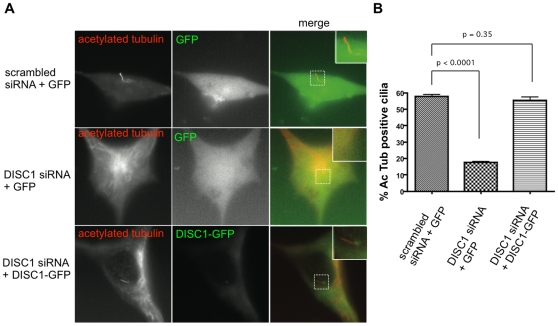
Rescue of the DISC1 knockdown phenotype by human-derived DISC1-GFP.NIH3T3 cells were transfected with siRNA targeting endogenous murine DISC1 and transduced with lentiviral particles encoding human-derived DISC1-GFP lacking the target sequence. (A) Example images from the rescue experiment. Top panels show the negative control condition, in which cells were transfected with scrambled (non-silencing) siRNA and infected with a lentivirus encoding GFP. Middle panels show the knockdown condition, in which cells were transfected with DISC1 siRNA and infected with lentivirus encoding GFP. Bottom paneles show the rescue condition, in which cells were transfected with DISC1 siRNA and infected with lentivirus encoding the siRNA-resistant DISC1-GFP construct. Left panels show acetylated tubulin immunoreactivity, middle panels show GFP fluorescence, and right panels show the merge image with inset as indicated by box. (B) Quantification of the rescue effect by cilia count (n = 4 experiments).